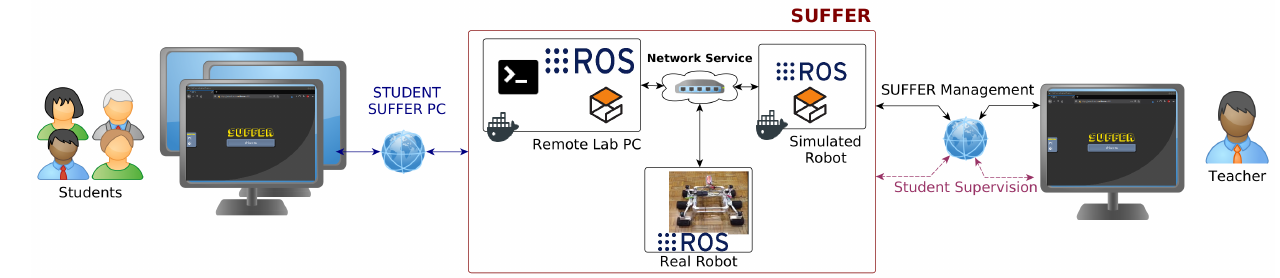
Figure 1. SUFFER